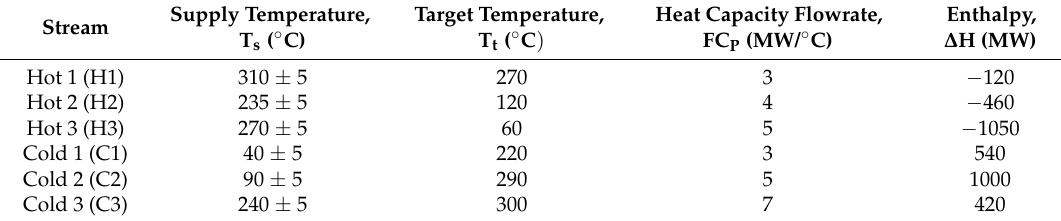
Table 1. Stream data for nominal operation.